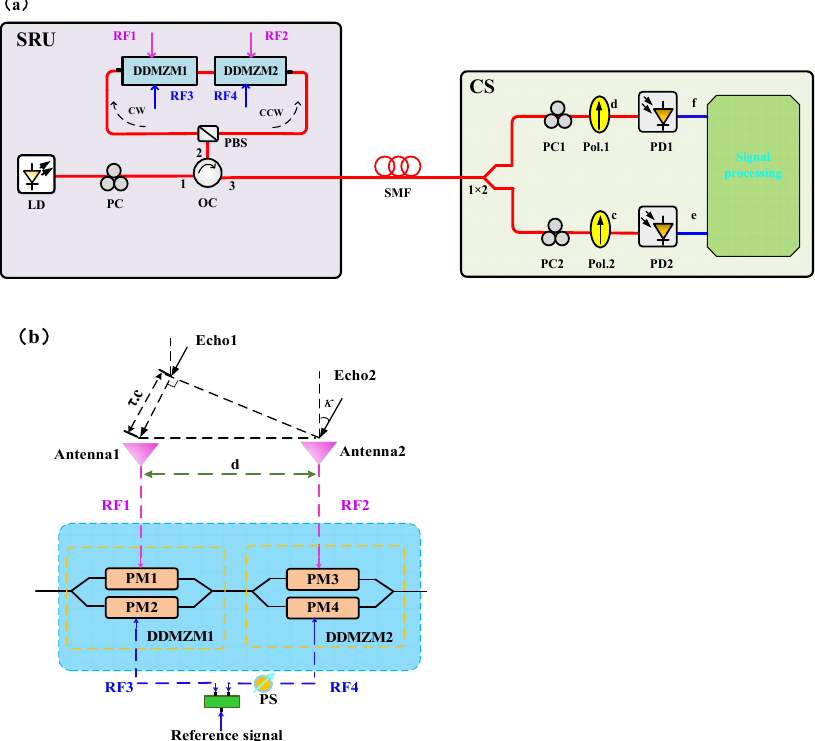
Figure 1. Schematic diagram of ( a ) the system for simultaneous DFS and AOA measurement. LD: laser diode; PC: polarization controller; OC: optical circulator; PBS: polarization beam splitter; DDMZM: dual-drive Mach–Zehnder modulator; SMF: single mode fiber; Pol: polarizer; PD: photodetector; PM: phase modulator; PS: phase shifter; CS: the central station, SRU: signal receiving unit. ( b ) Configuration of DDMZM1 and DDMZM2.